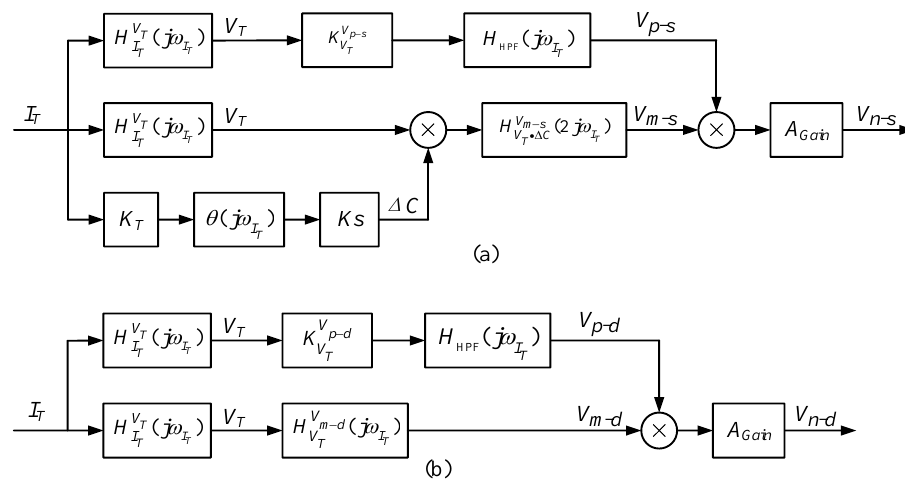
Figure 16. ( a ) Optimized SCM detection circuit noise transfer system structure; ( b ) Optimized DCM detection circuit noise transfer system structure.